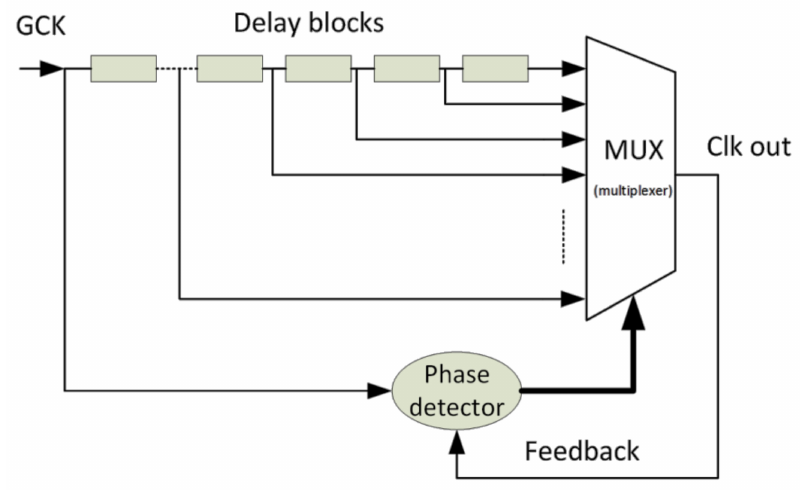
Figure 4. Block diagram of the Digital Clock Manager (DCM) delay